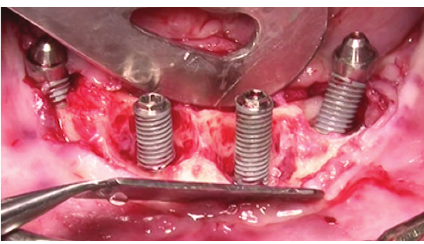
Figure 8: Surgical access to the peri-implant bone